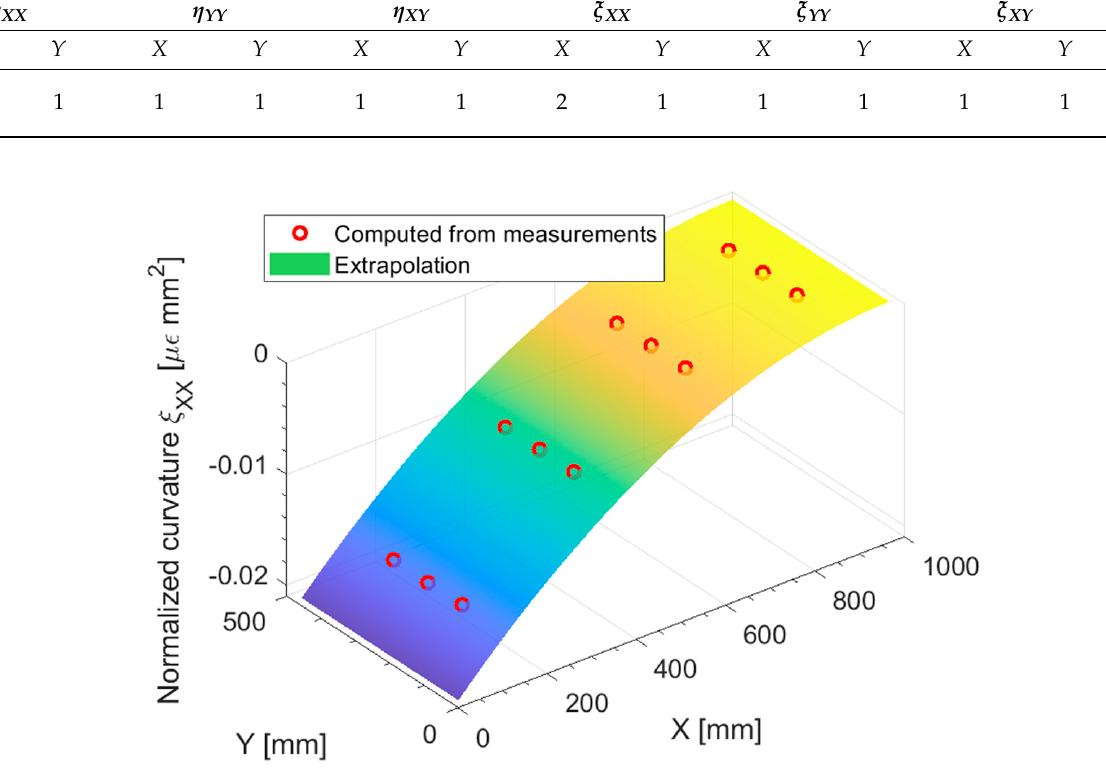
Figure 14. Uniform pressure: normalized curvature ξ XX